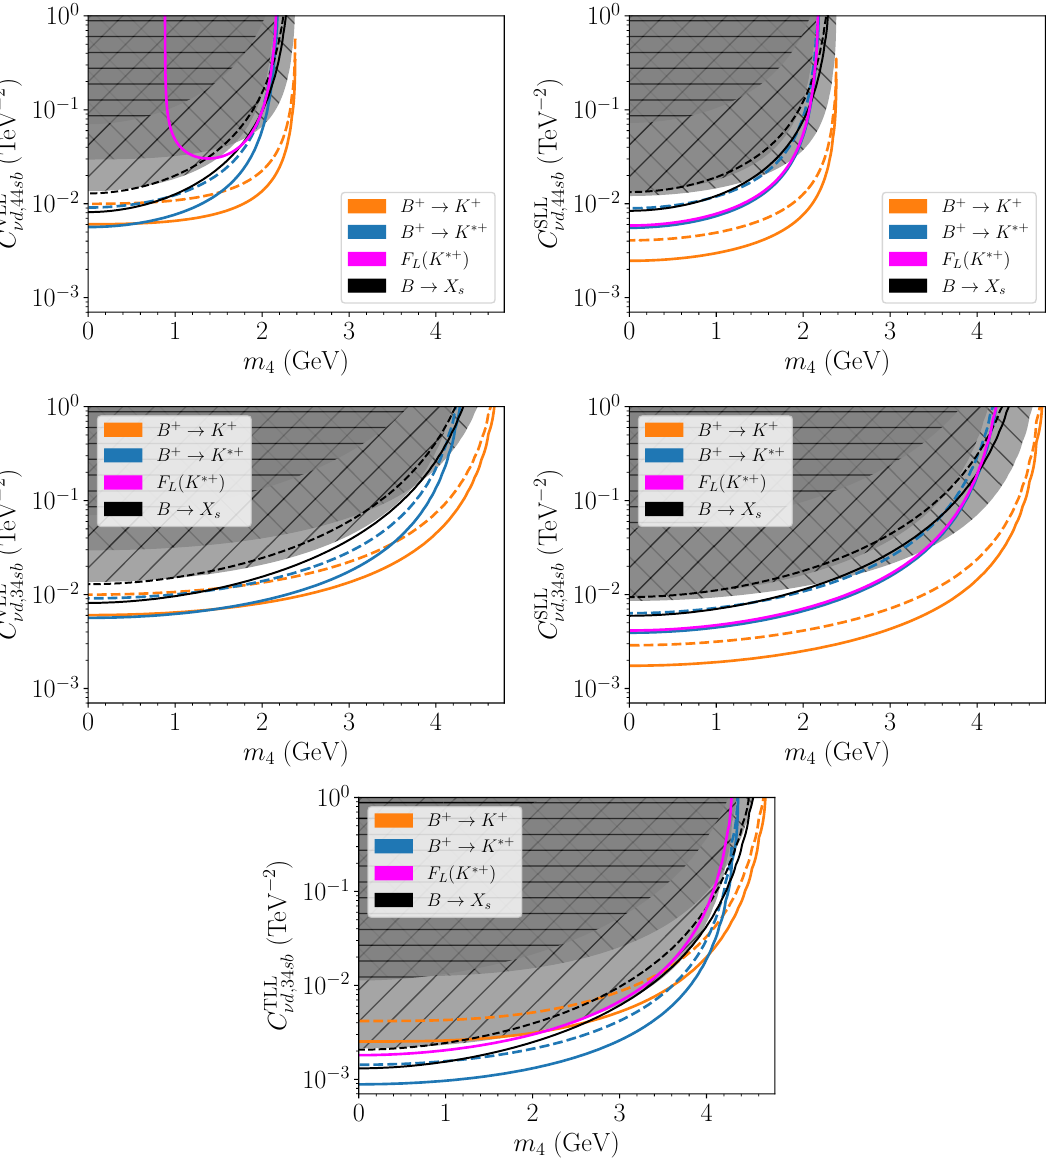
Figure 4 . Current (shaded regions) and future sensitivities (lines) on a single Wilson coefficient as a function of the mass of two sterile neutrinos (top panel) and one sterile neutrino (middle panel and bottom plot) in the final state, respectively. We assume that the Belle-II results for 5 ab − 1 (dashed lines) and for 50 ab − 1 (solid lines) for several b → sνν observables will confirm the SM predictions. We use the sensitivities referenced in [3] and assume an experimental uncertainty of 50% (solid line) and 20% (dashed line) for the inclusive decay B → X s νν . Regions with \\ (//) [–] hatching are excluded via the current bounds on B + → K + νν ( B 0 → K ∗ 0 νν ) [ B → X s νν ]. The constraints are identical if exchanging the third neutrino flavour α = 3 for α = 1 , 2